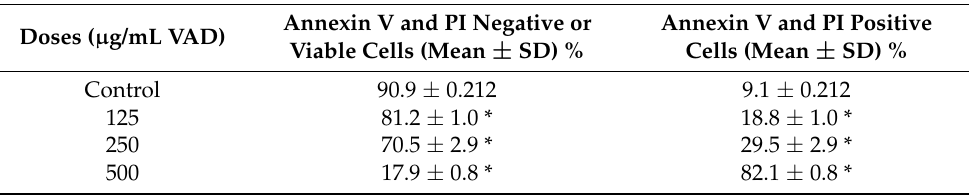
Table 1. Summary of annexin V/PI data obtained from flow cytometry (Figure 6). Human prostate adenocarcinoma (PC-3) cells were cultured in the absence or presence of VAD for 48 h as described in the Materials and Methods section. Values are shown as the means ± SD of three replicates per experiment.